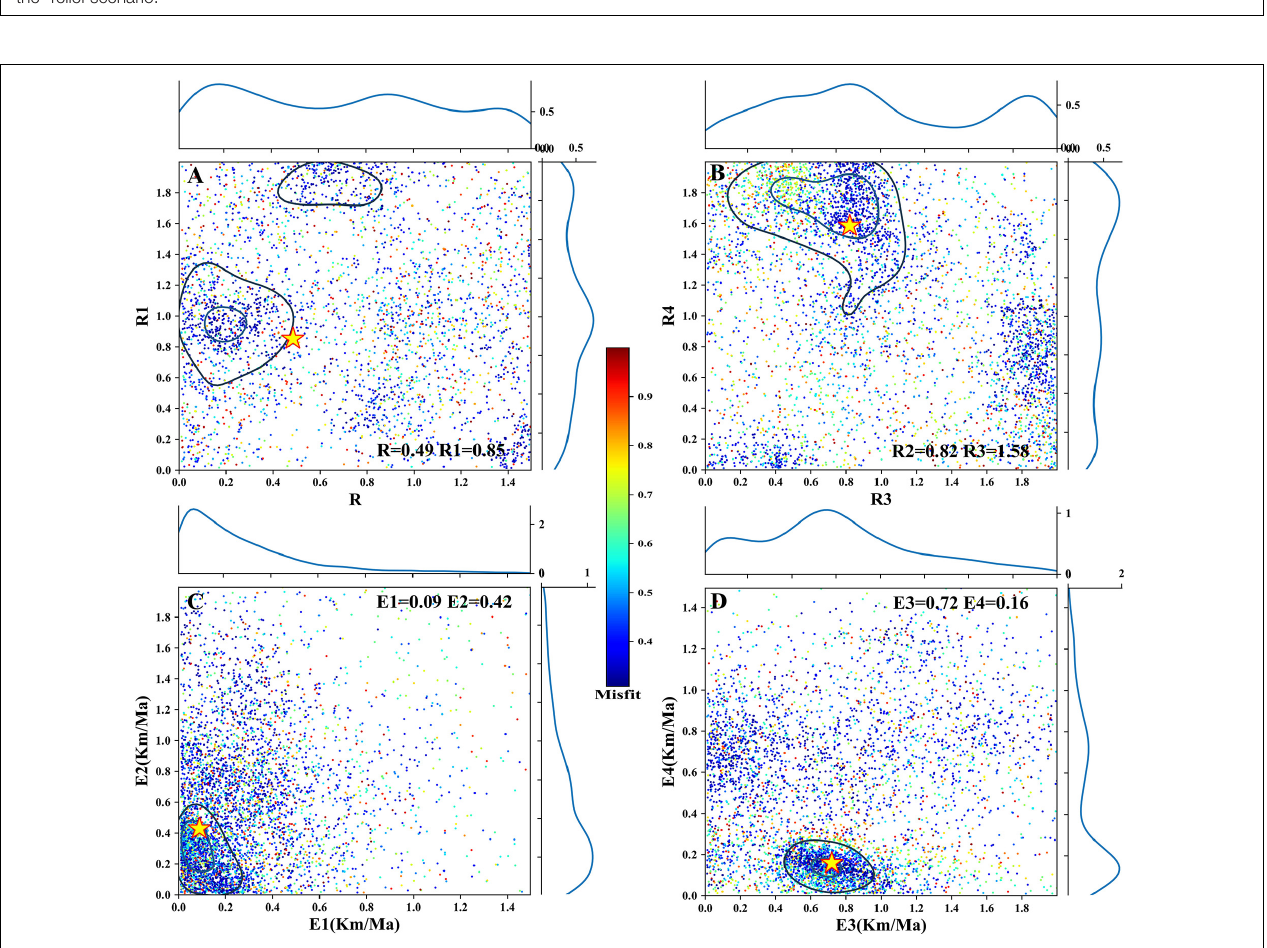
FIGURE 6 | Scatterplots of Pecube inversion misfits for the relief scenario model of the Lhasa River drainage. Colored dots represent individual forward-model runs plotted in 2D projections of the parameter space with colors corresponding to misfit values. Posterior probability density functions for parameter values are plotted along the axes. The best-fit solution is represented by a yellow star with 2 σ (black) and 1 σ (light blue) confidence contours. (A–D) Relief factor and denudation rate during the four stage (relief factor R , R1, R2, and R3; denudation rate E1, E2, E3, and E4).